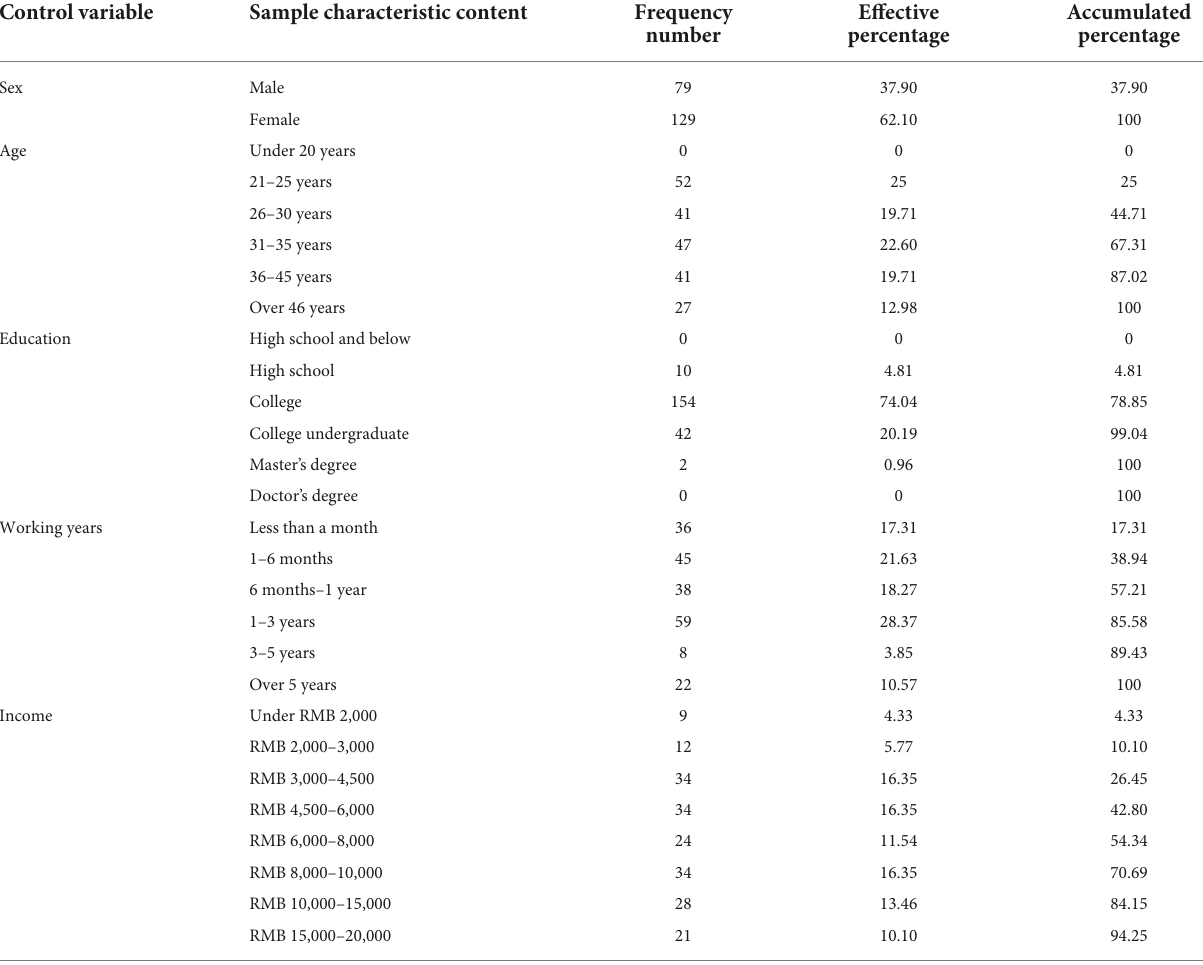
TABLE 2 Demographic information of valid survey sample composition ( N = 208). Control